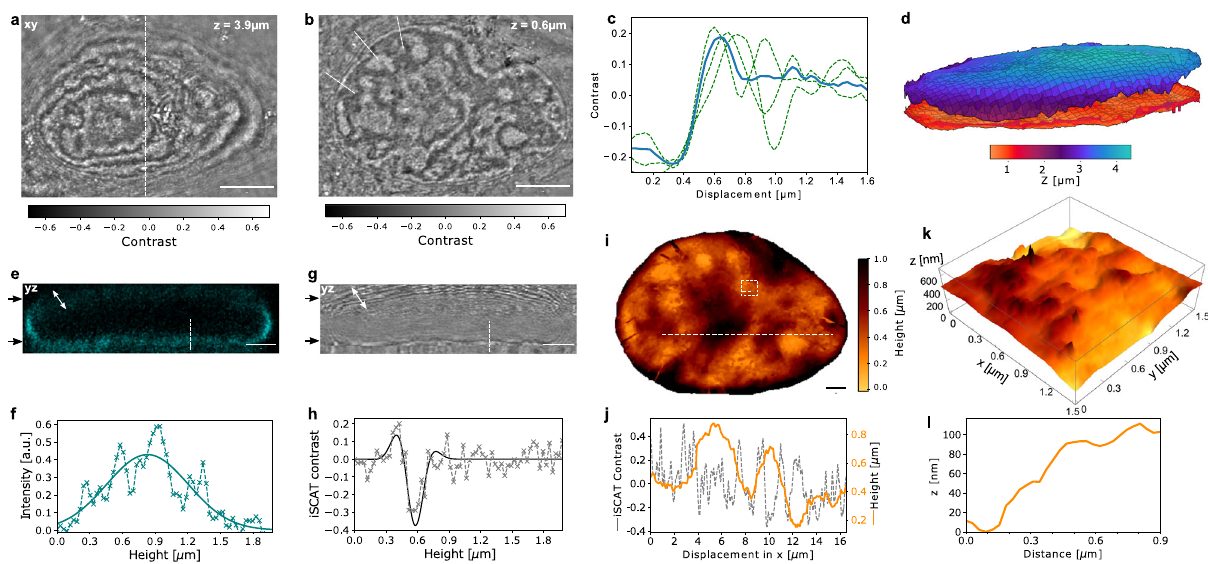
Fig. 2|3D imagingofthenucleusanditsenvelopetopography. C-iSCAT z -stack of a HeLa cell recorded at two representative focal planes of the apical nuclear envelope at 3.9 μ m ( a ) and the basal nuclear envelope at 0.6 μ m above the cover glass( b ).Eachimagewasrecordedin1sandwasbackgroundcorrected.Scalebars are 5 μ m. c Edge sharpness analysis. Three exemplary line cuts with a linewidth of 50 pixels each (green dashed lines) and the average hereof (blue solid line). d 3D representation of the basal and apical nuclear envelope. e Projection along the yz plane (along the white dashed line as indicated in a ) of the fl uorescence signal simultaneously recorded from the nucleus, which was transfected with mCherry- laminA. f Axial line cut from the basal envelope (symbols) and a Gaussian fi t (solid curve)alongthedashedlinein e . g C-iSCATcounterpartof e .Blackarrowsindicate